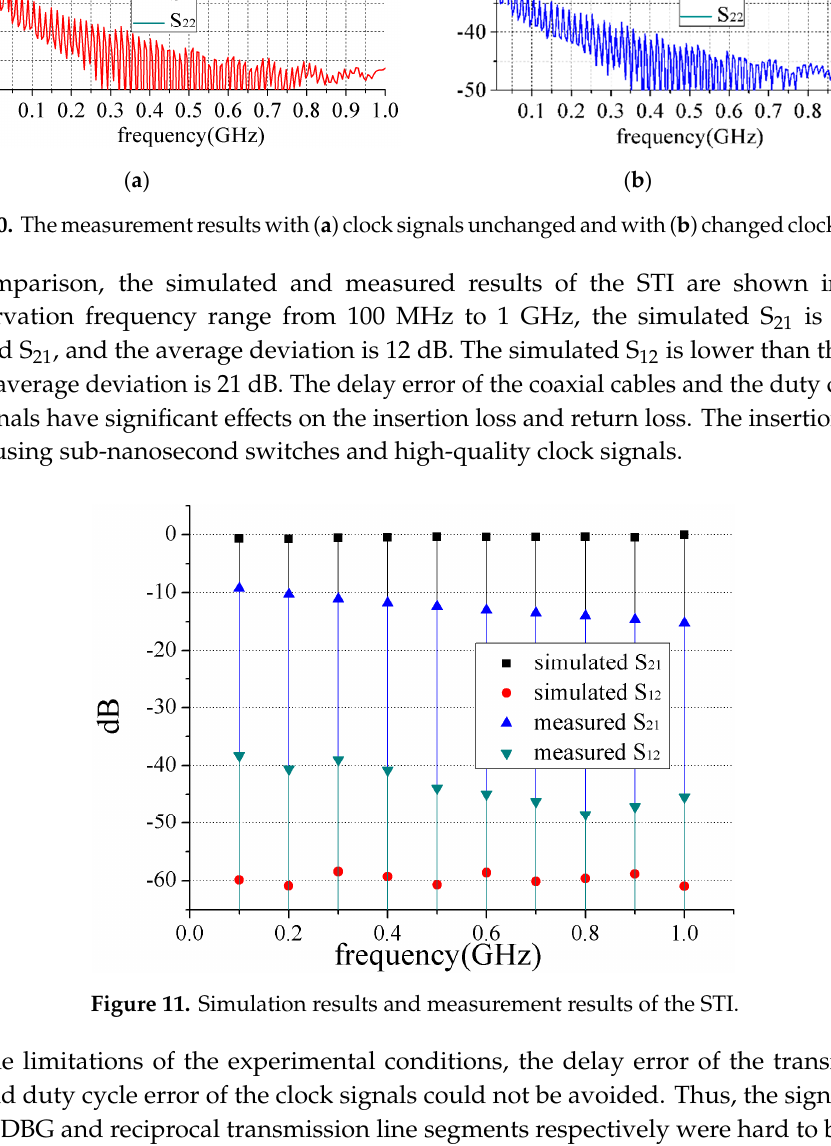
Figure 9. The prototype of the STI.